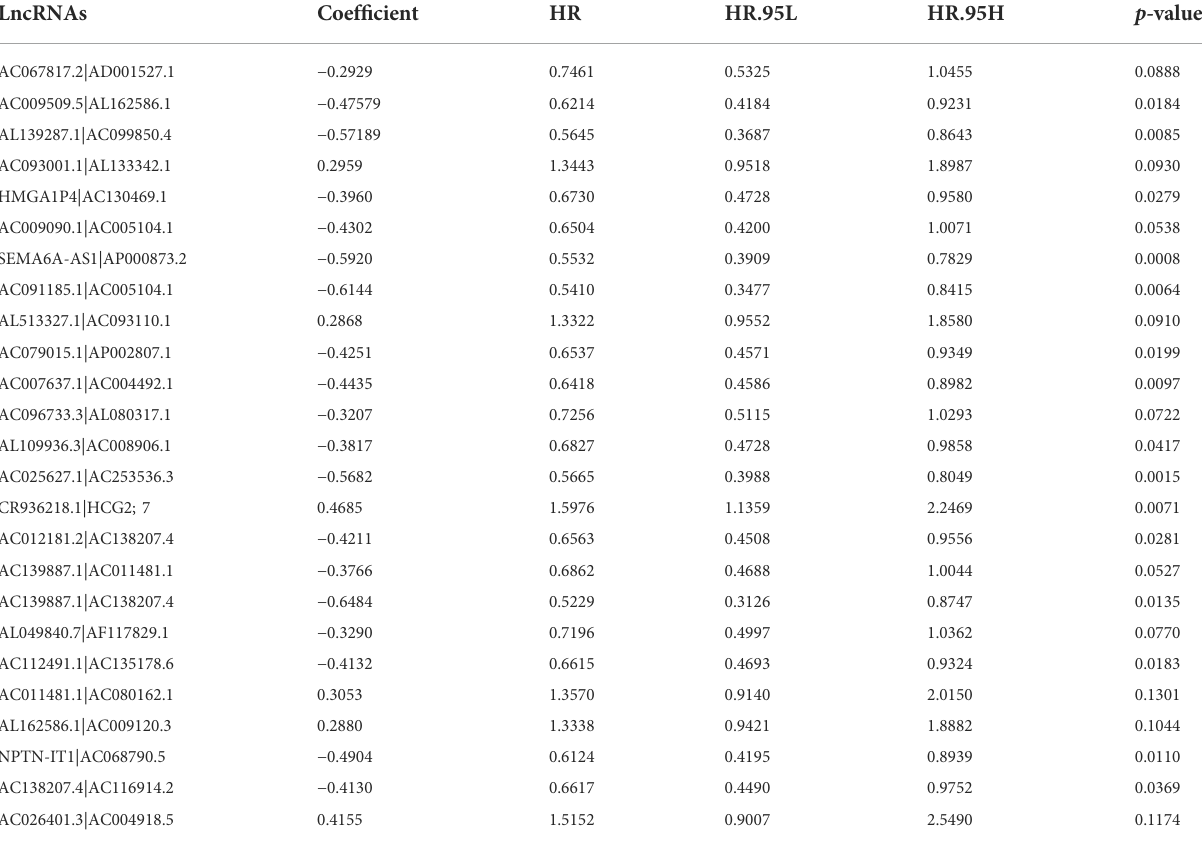
TABLE 1 25 prognostic nrlncRNA pairs multivariate COX regression study